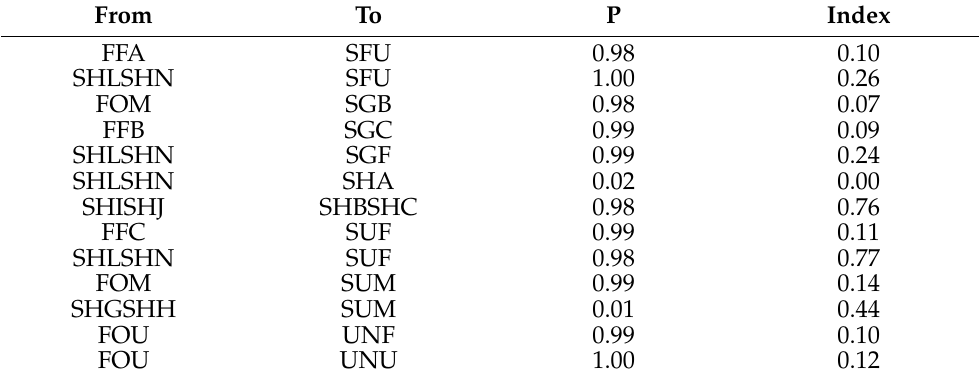
Table A7. Cont. From